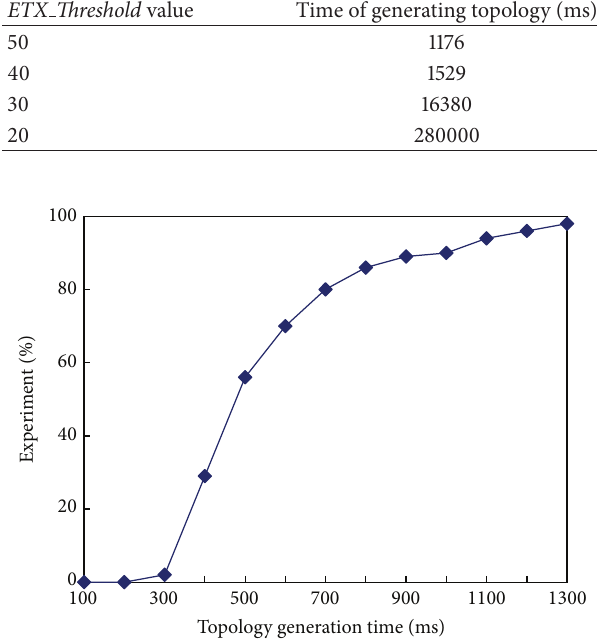
Figure 4: Distribution of time of generating topology when ETX Threshold = 50.